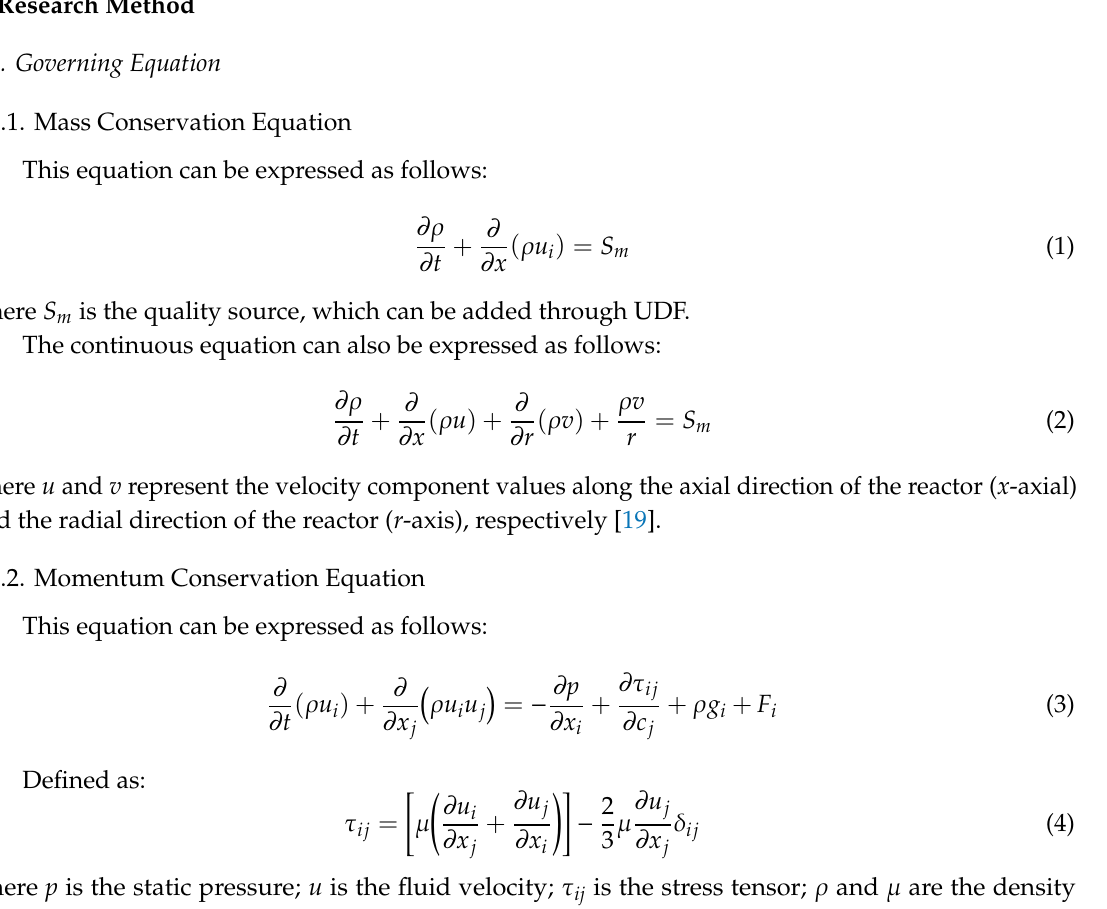
Figure 2. Physical model and meshing of the microreactor.